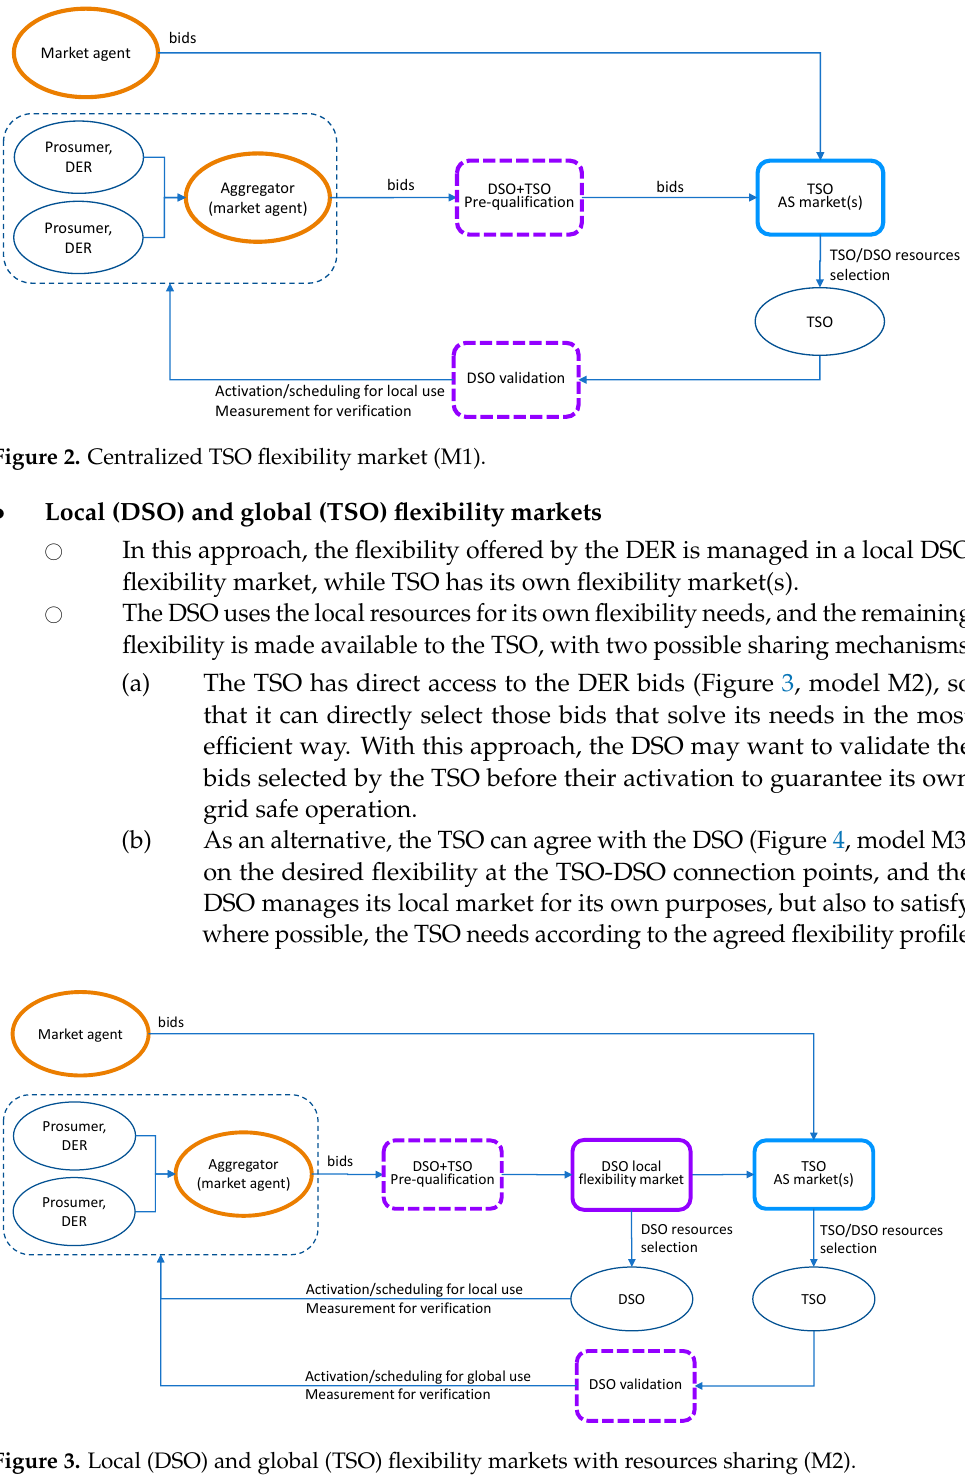
Figure 4. Local (DSO) and global (TSO) flexibility markets with shared responsibility (M3). •